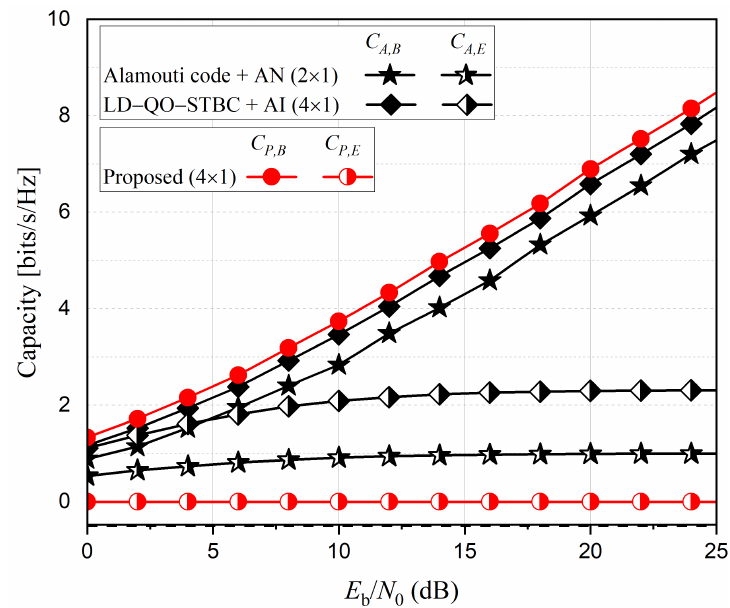
Figure 6. Capacity comparison of various PLS schemes at Bob and